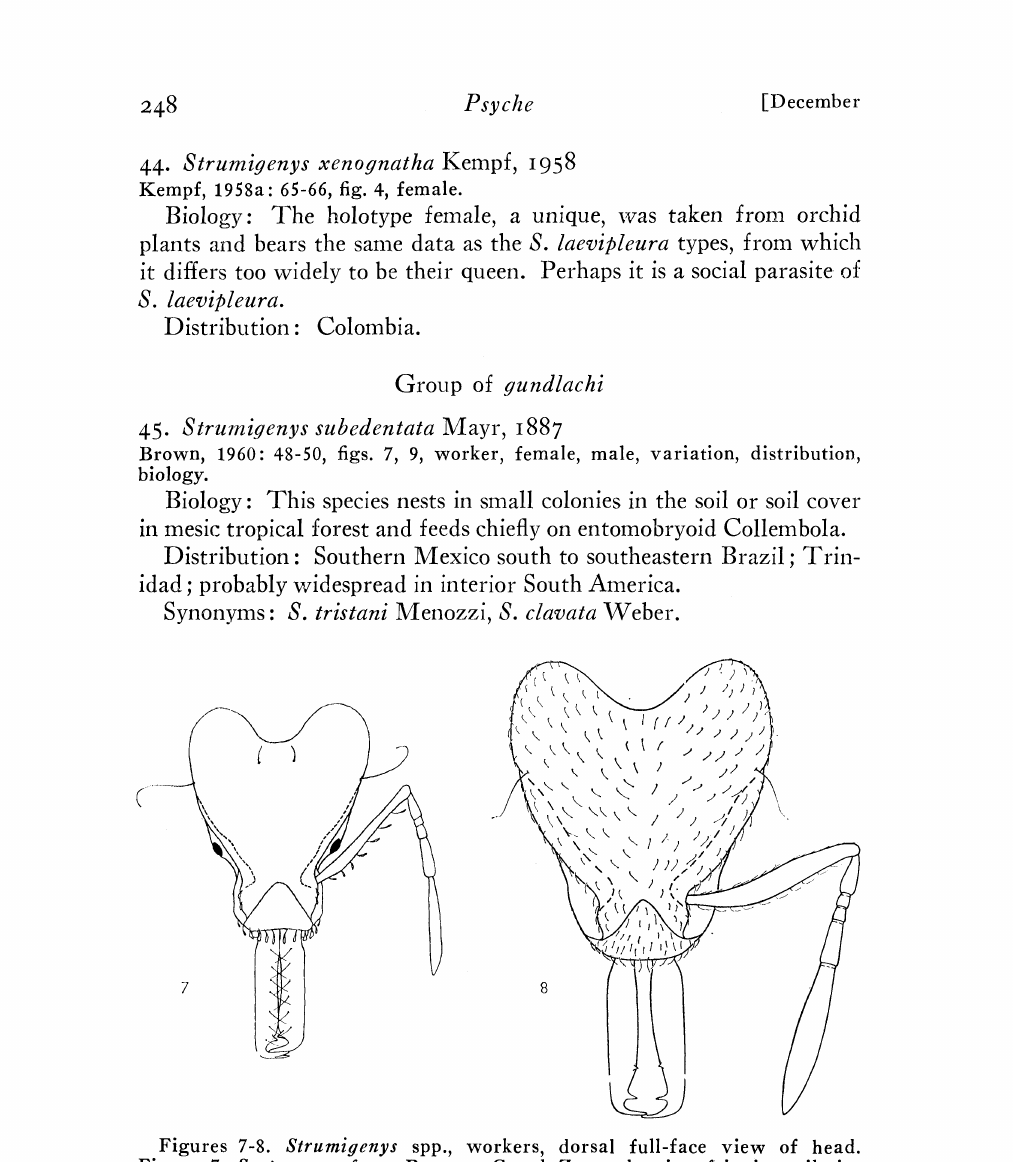
Figures 7-8. Strumigenys spp., workers, dorsal full-face view of head. Figure 7, S. precaea from Panama Canal Zone, showing fringing pilosity only. Figure 8, S. hindenburgi from Tucumin, Argentina. Not to same